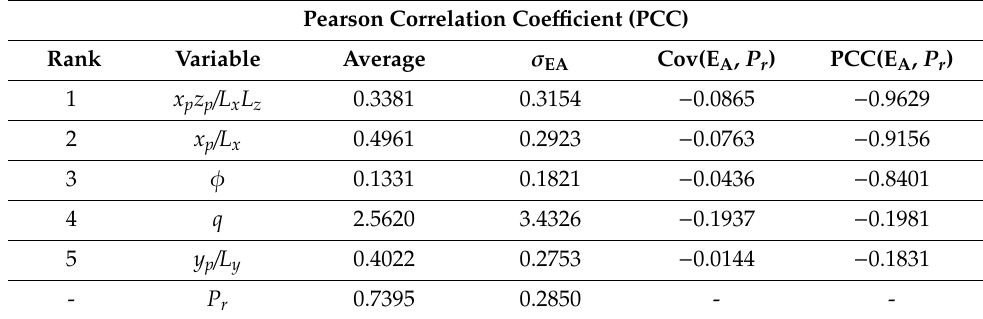
Table 2. Multivariate covariance analysis of geometrical factors and P r